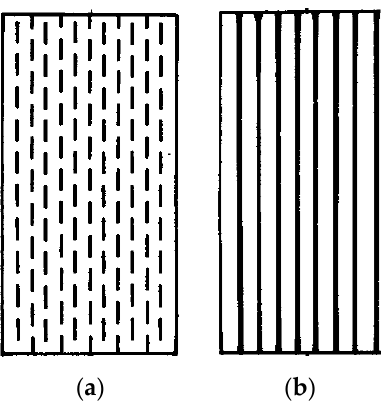
Figure 1. Composites reinforced with unidirectional ( a ) discontinuous and ( b ) continuous fibers.